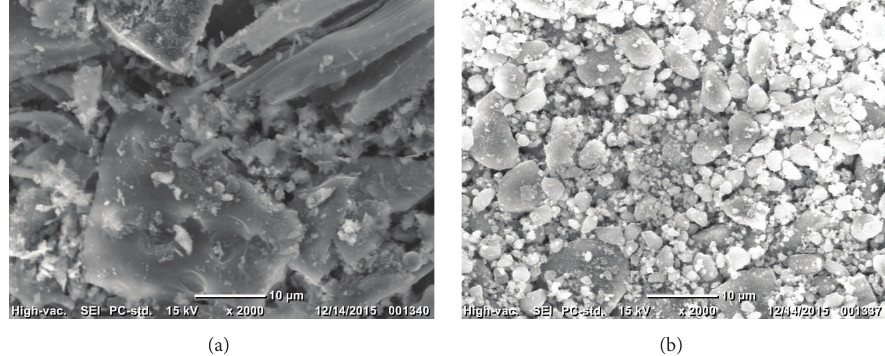
Figure 9: SEM images of (a) rice husk without undergoing the milling process and (b) rice husk after undergoing a 30-hour milling process.